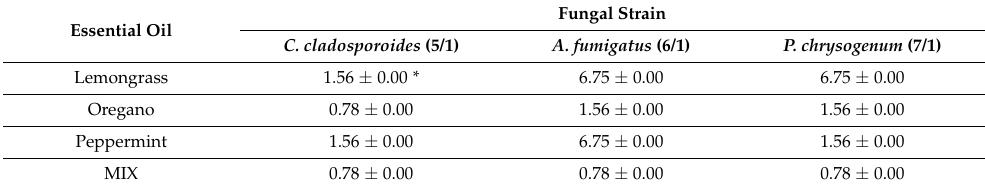
Table 2. The results of minimal inhibitory concentration (%) * ± standard deviation.